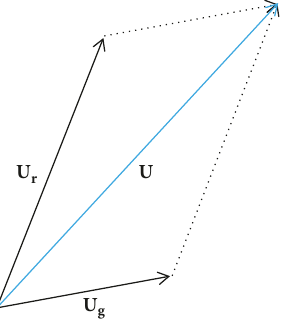
Figure 4: Schematic diagram of geometrical superposition princi-